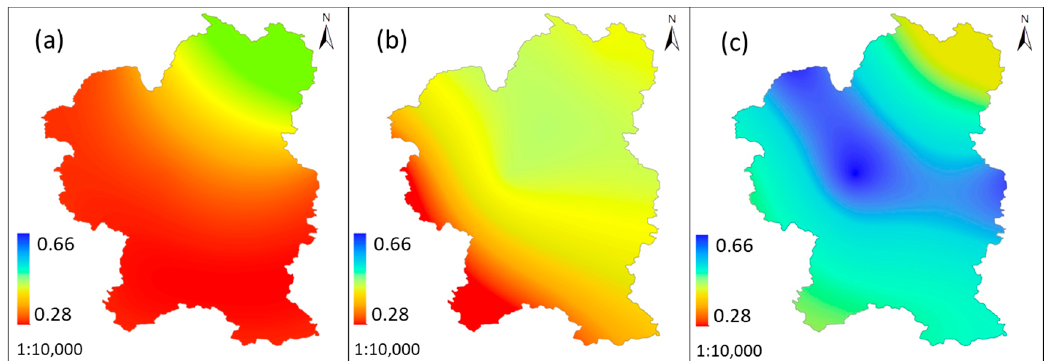
Figure 4. Distribution of runoff-migration influence factor in the study area (( a ) 2011; ( b ) 2012; ( c ) 2013).